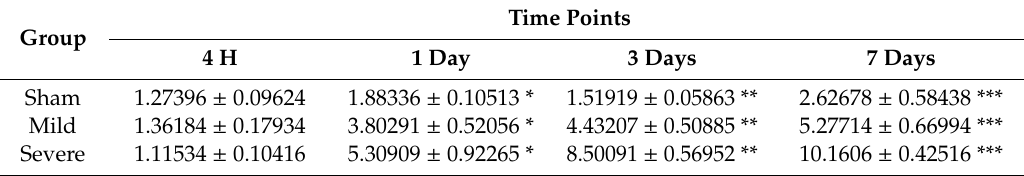
Table 2. Alterations in the level of miR-21 expression according to the course.